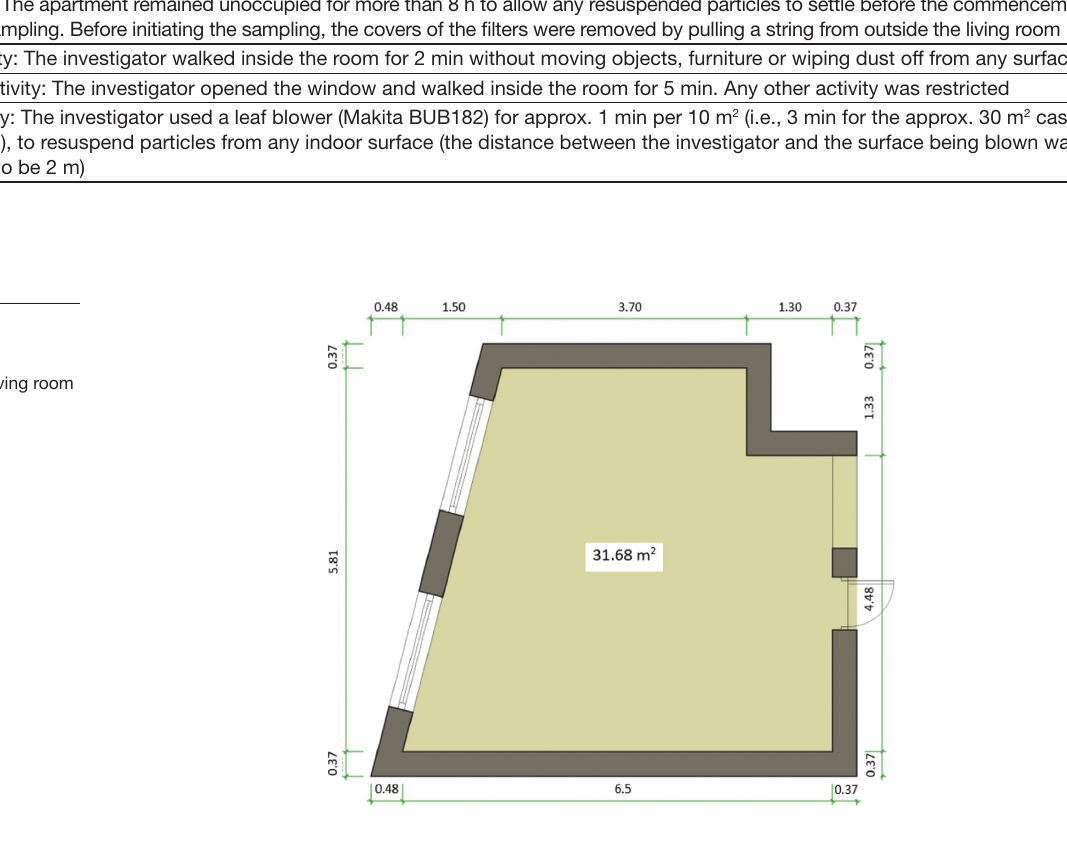
Table 3. Description of activities carried out in every test before sampling Experiment